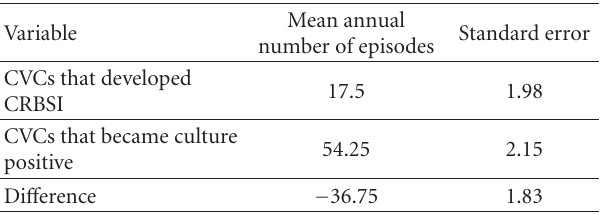
Figure 1: Annual incidence of culture-positive CVCs and CRBSI expressed as episodes per 1000 CVC days. Table 1: Comparison of CRBSI versus culture positive CVCs (episodes per year).